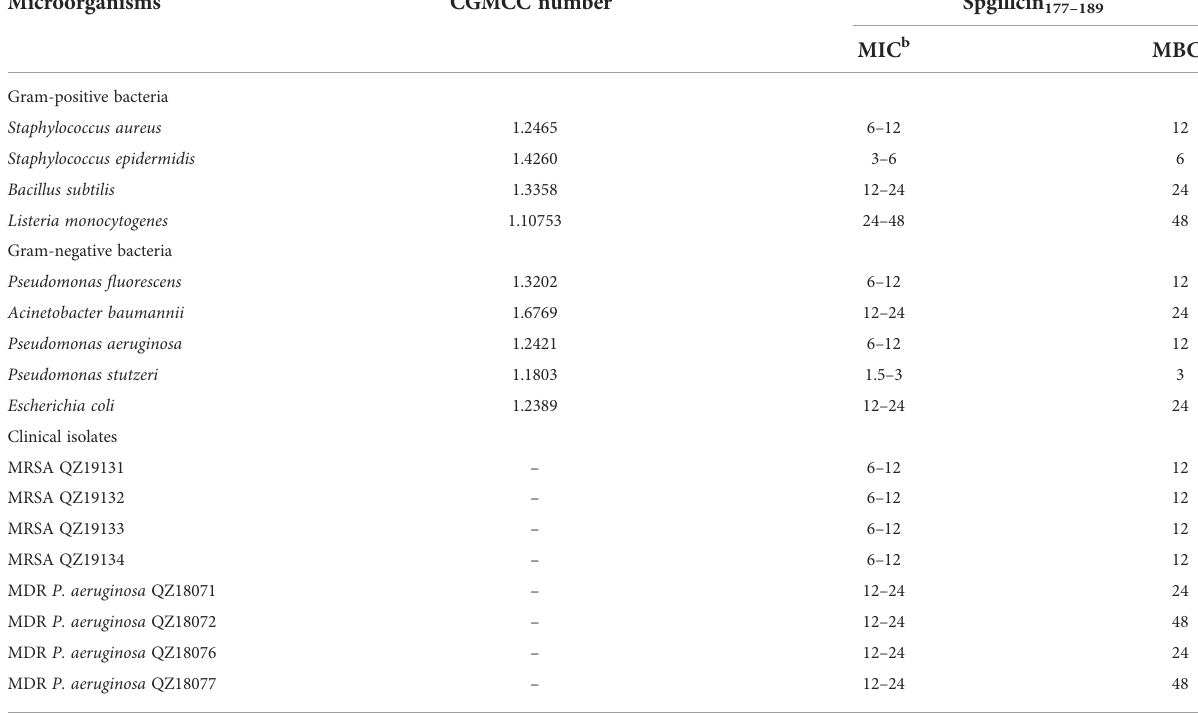
TABLE 1 Antimicrobial activity of Spgillcin 177 – 189 against microorganisms.